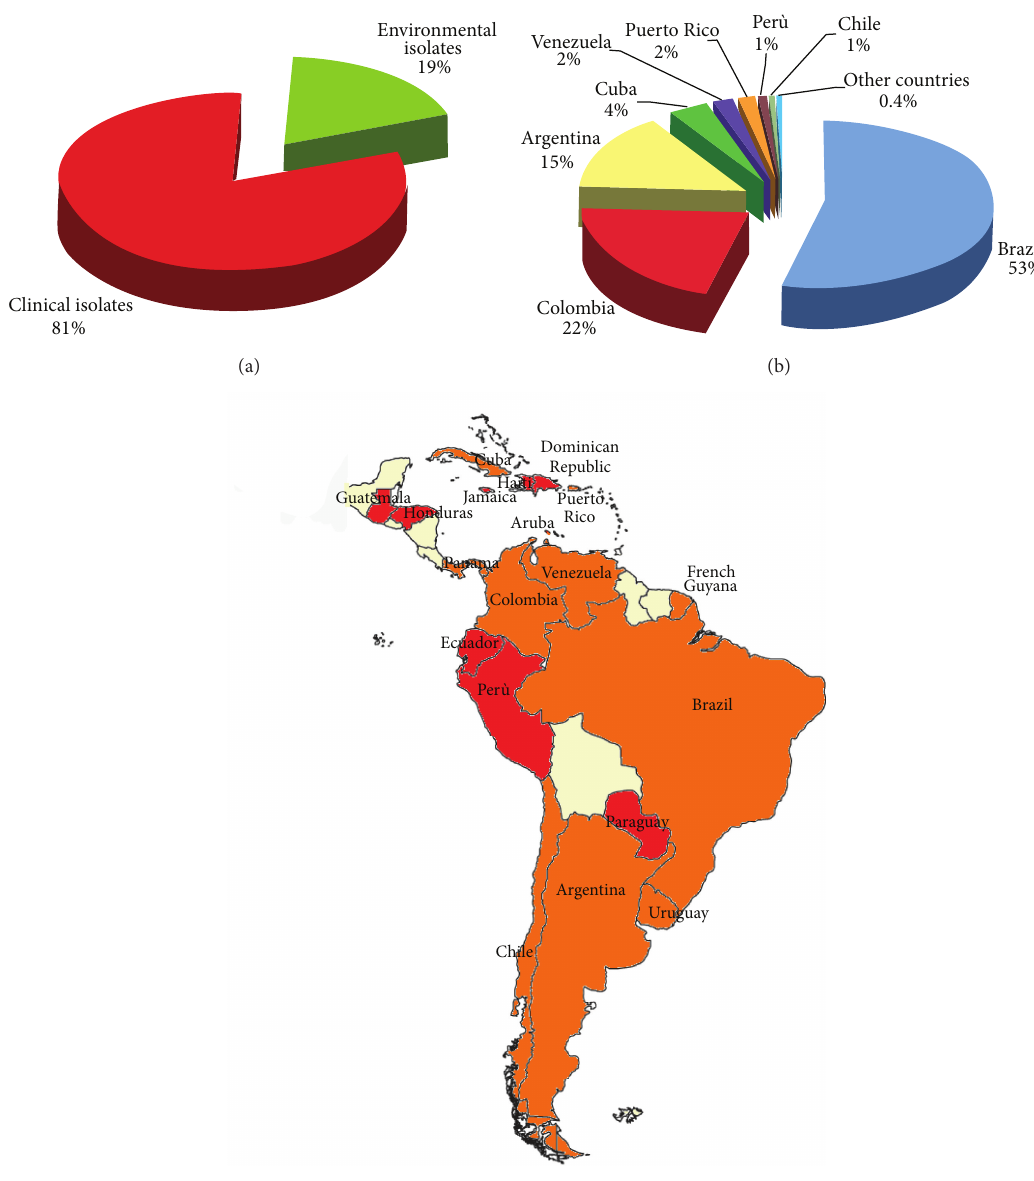
,590) and environmental ( ,958) 𝑛𝑛 𝑛 𝑛 𝑛𝑛 𝑛 𝑛